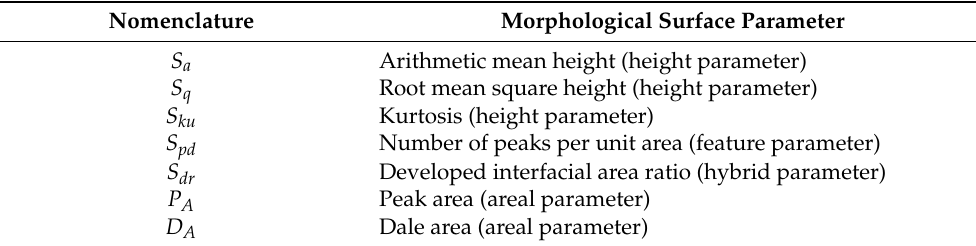
Table 4. Nomenclature of the morphological surface